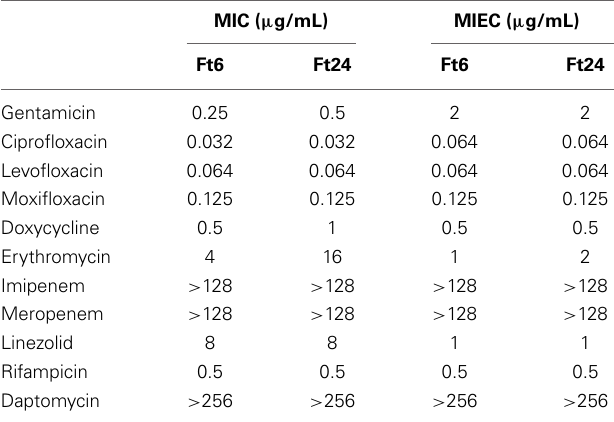
Table 2 | Activities of 11 antibiotics against two clinical strains (Ft6 and Ft24) of F. tularensis subsp. holarctica determined using a broth microdilution method and a dye uptake assay, respectively.